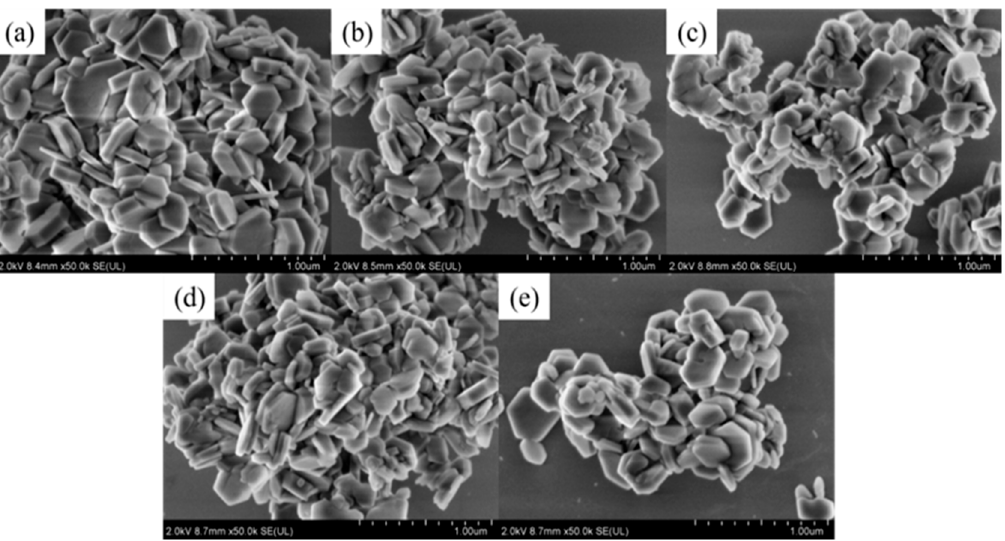
Figure 3. SEM micrographs of MH particles prepared with different NaOH concentrations: ( a ) 0